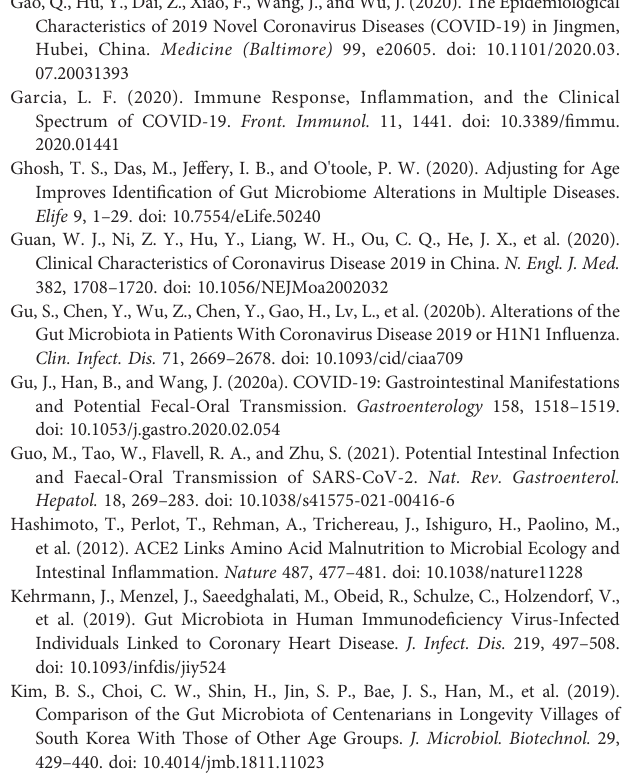
Supplementary Figure 1 | (A) Shannon diversity and Pielou´s evenness index in SARS-CoV-2positiveandnegativepatients.Kruskal-Wallis testwas usedtotestfor signi fi cant differences among groups. (B) Principle coordinates analysis of weighted UniFrac, unweighted UniFrac and Bray Curtis distance matrices. PERMANOVA multivariate analysis was used to test for signi fi cant differences. Supplementary Figure 2 | Different alpha diversity metrics illustrated by Shannon diversity index, observed features (ASVs) and Pielou´s evenness index in SARS- CoV-2 positive patients with (positive) and without (negative) diarrhea. (B) PCoA of principle coordinate 1 and 2 of weighted and unweighted UniFrac, Bray Curtis and Jaccard distance matrices in SARS-CoV-2 positive patients with (positive) and without (negative) diarrhea. (C) Visualization of the relative abundance of the 20 most abundant genera in SARS-CoV-2 positive patients with (positive) and without (negative) diarrhea. Supplementary Figure3 | IllustrationoftotalnumberofBcells(CD19 + Bcells),NK cells (CD3 - CD16 + CD56 + NK cells), CD3 + CD16 + CD56 + natural-killer like T cells, HLA DR + T cells and thrombocytes in COVID-19 patients according to disease